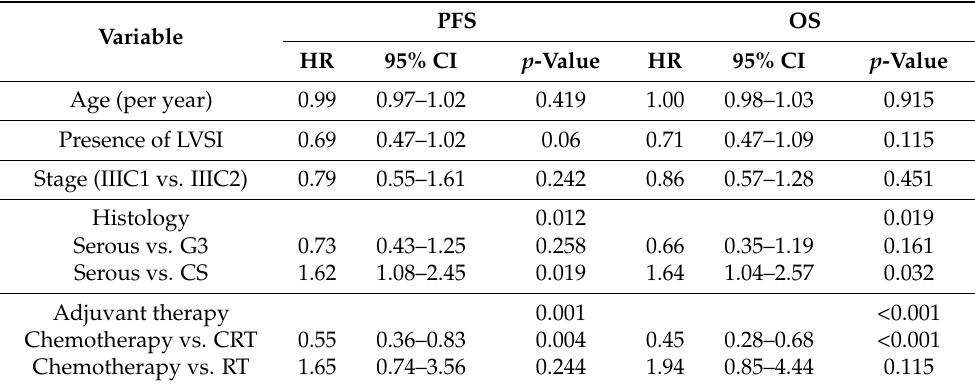
Table 3. Multivariate analysis for PFS and